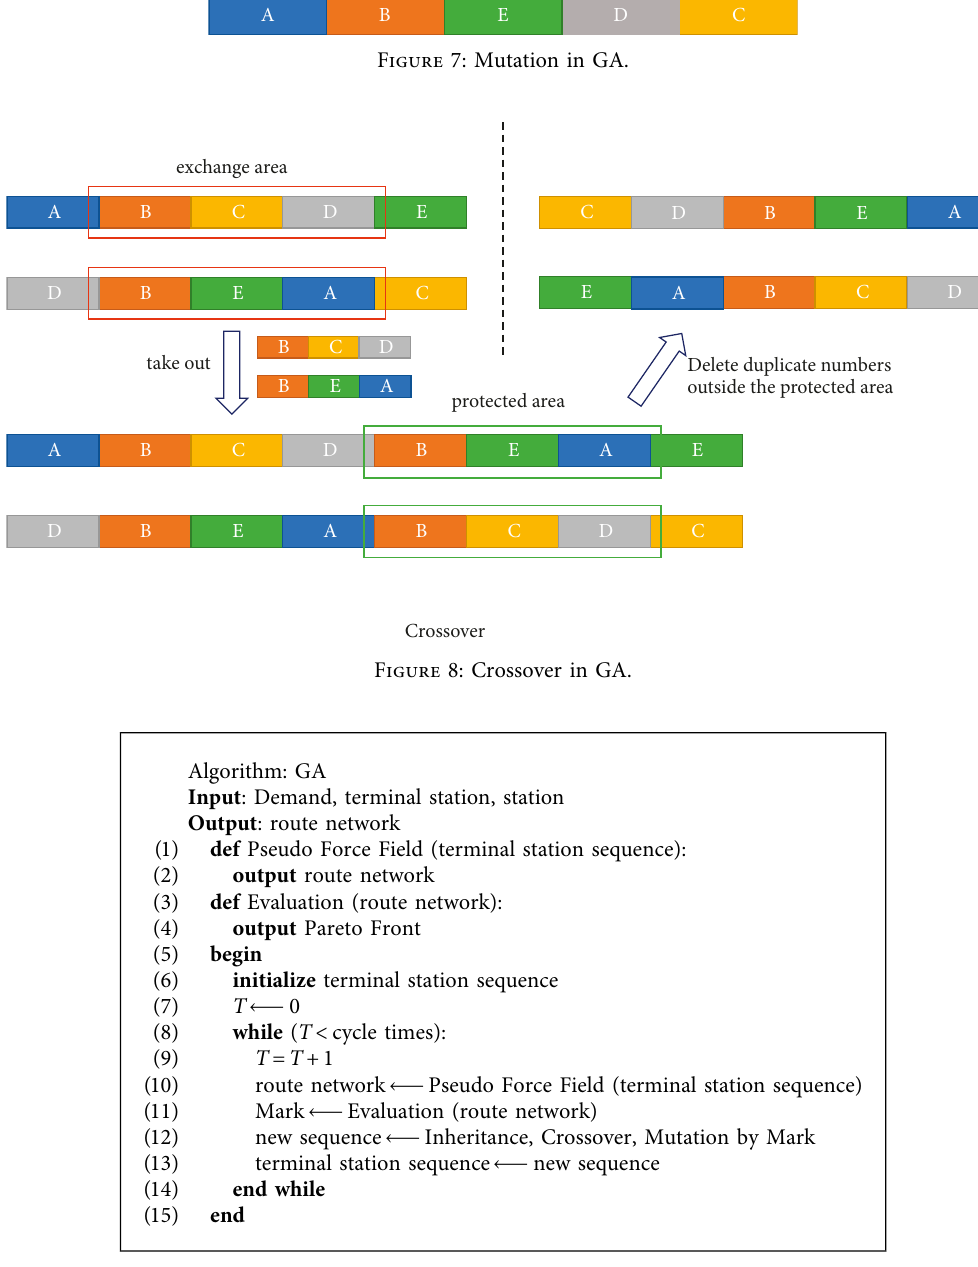
A LGORITHM 1: Pseudocode for the optimization